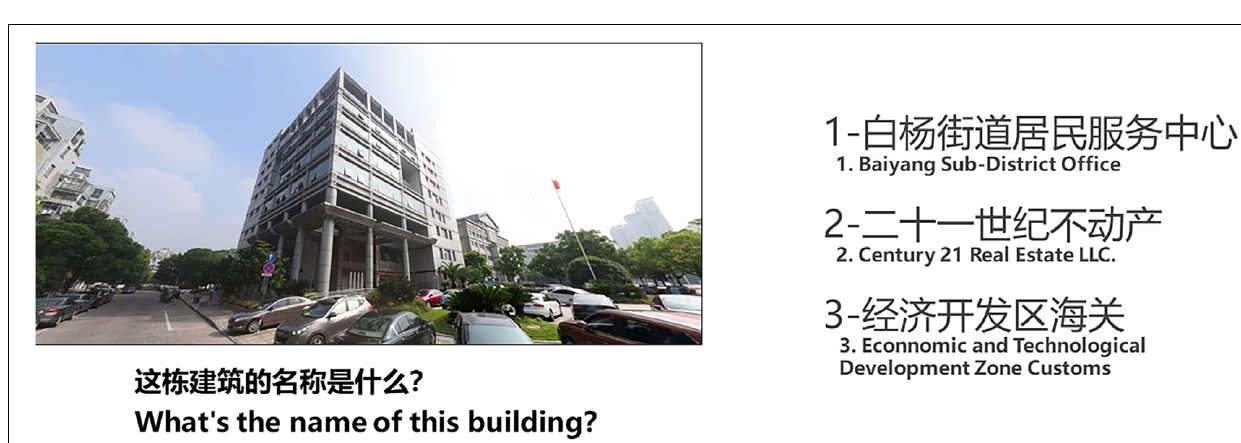
FIGURE 5 | One screenshot of displays of street view map learning.